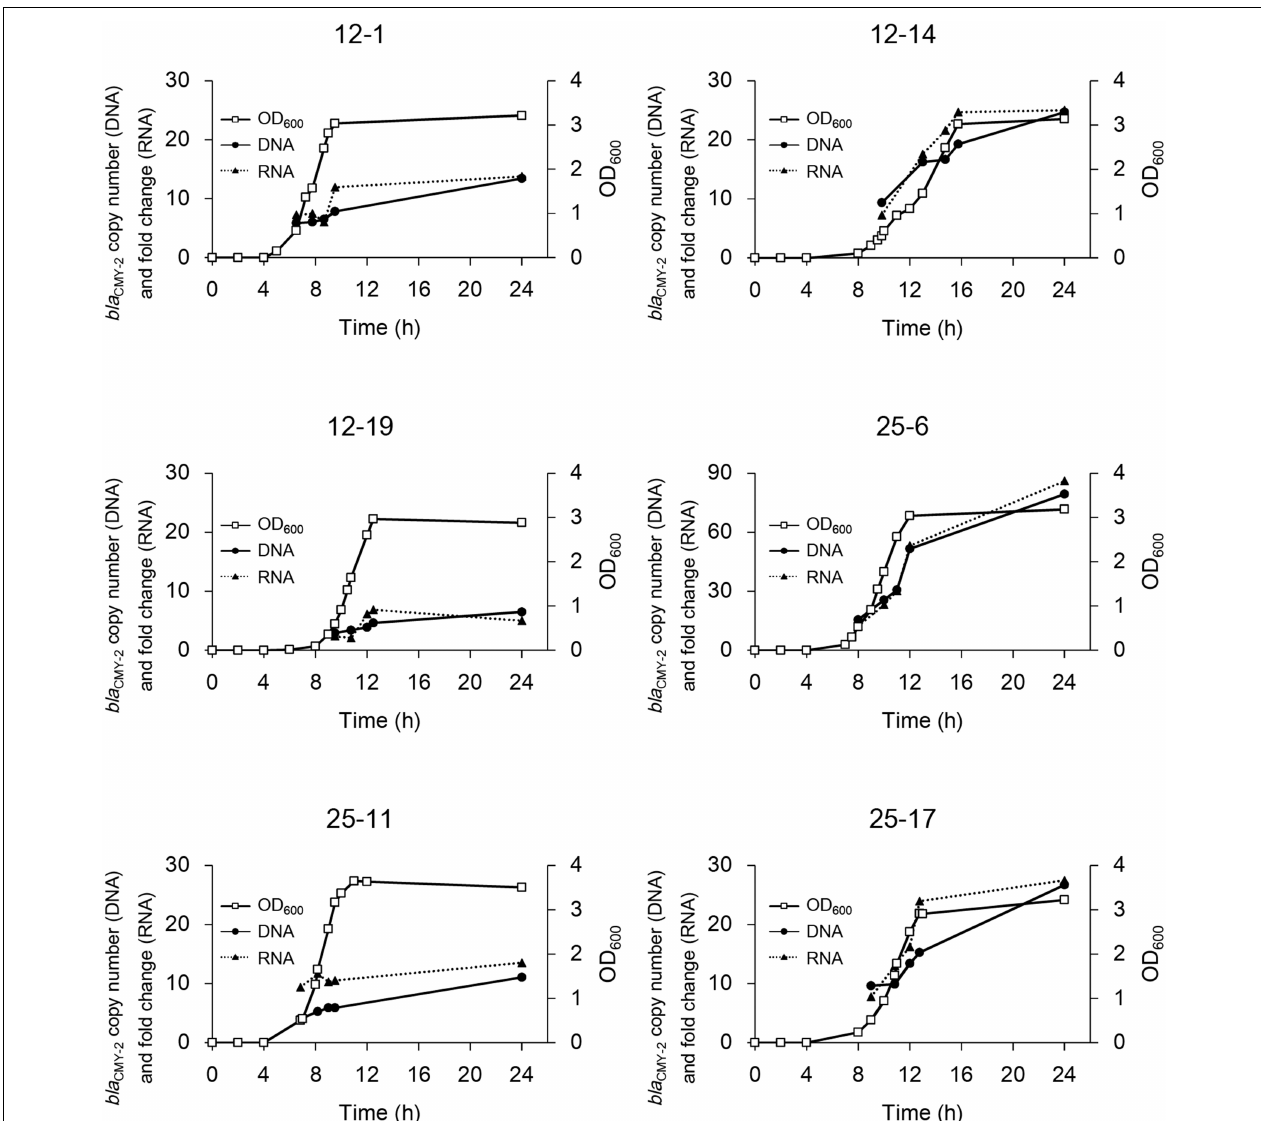
FIGURE 2 | Time courses of bacterial growth and bla CMY − 2 gene amplification in the six selected mutants. Bacterial growth is shown as OD 600 . The copy number of gene and fold change of mRNA are indicated. Note that the y-axis for strain 25-6 is different from that for the others.